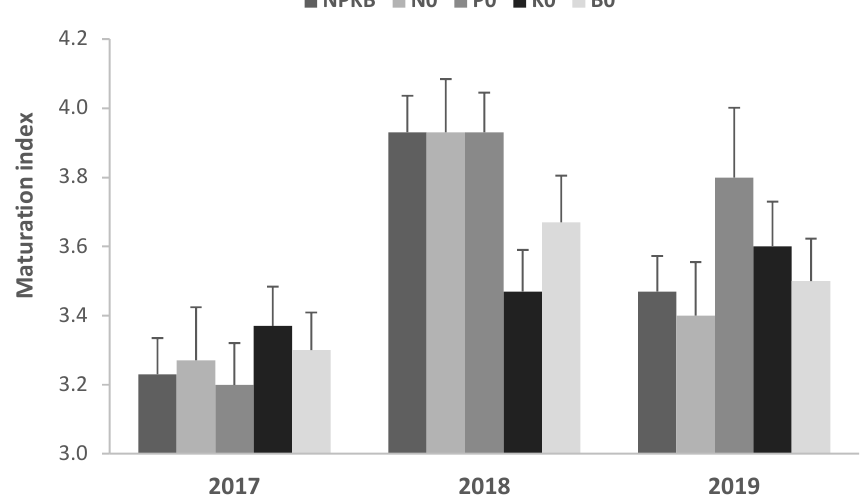
Figure 2. Maturation index of olives from trees supplied with NPKB (control) and without N (N0), P (P0), K (K0) and B (B0) in the harvests of 2017, 2018 and 2019. Vertical bars represent the standard errors.